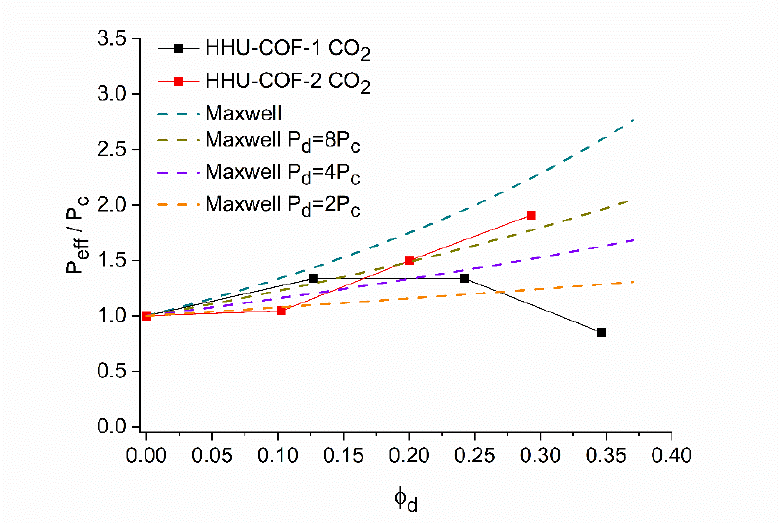
Figure 10. P eff / P c of the gas CO 2 versus φ d for 0 to 24 wt% HHU-COF-1 and HHU-COF-2 as dispersed phases in Matrimid